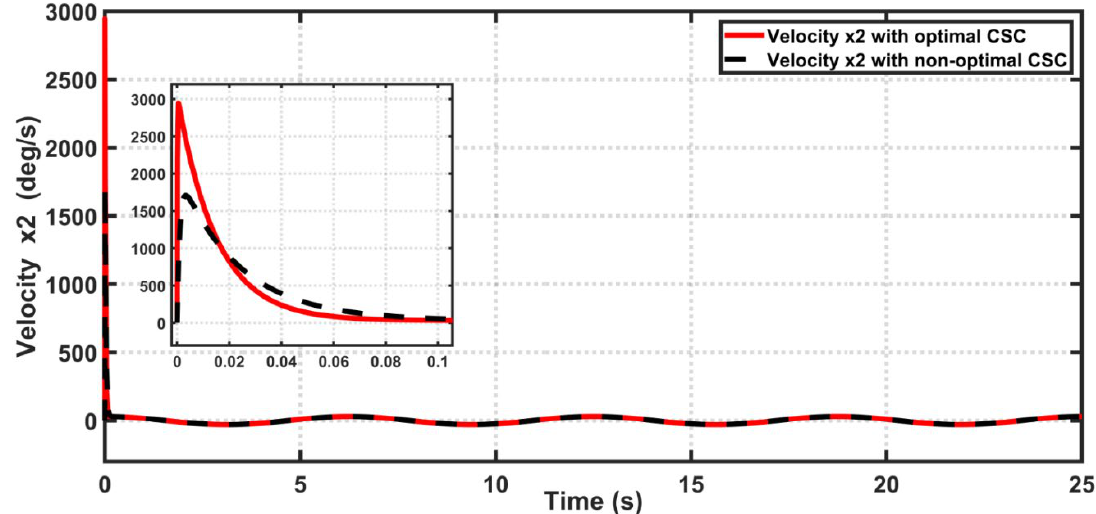
Figure 9. The responses of tracking errors based on non-optimal and optimal ASC.